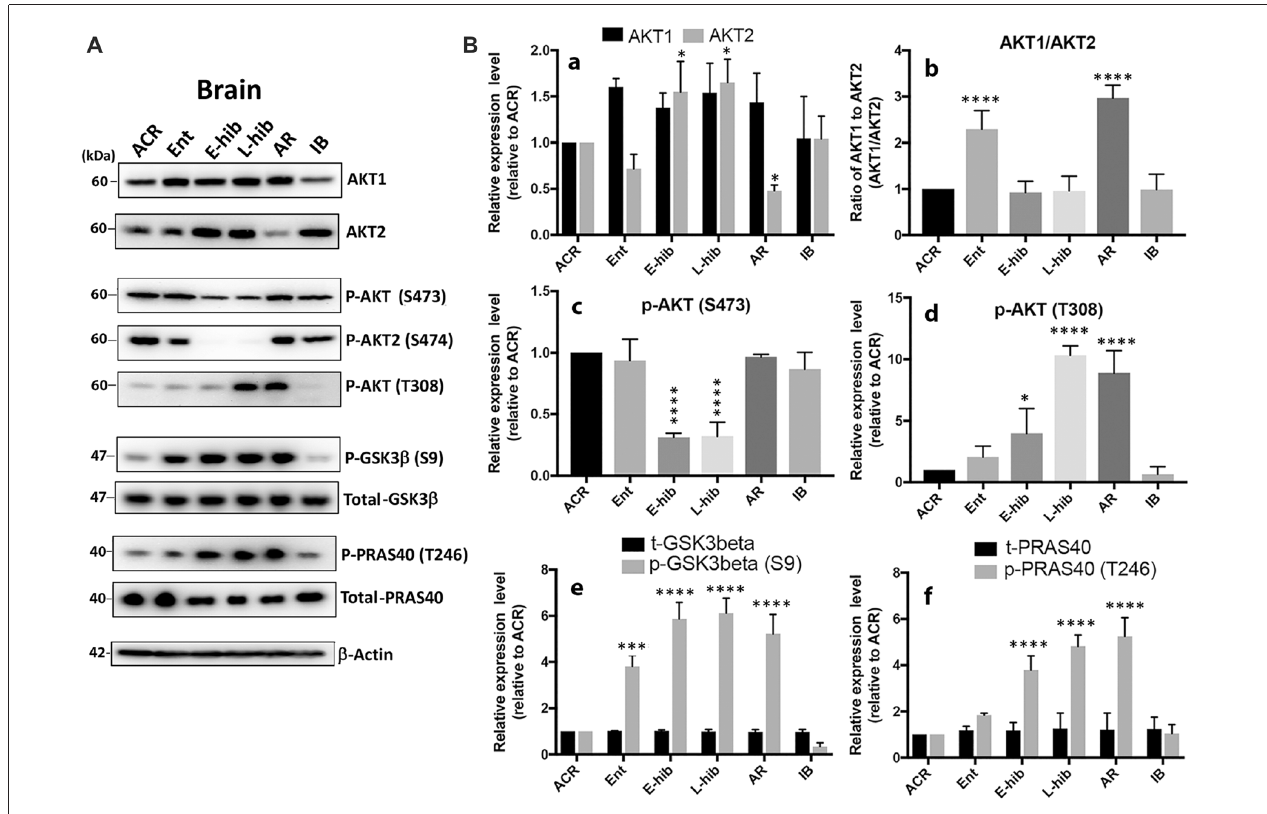
FIGURE 4 | Akt isoforms (Akt1 and Akt2) are differentially expressed in the brain of 13-lined ground squirrels during hibernation bout. (A) Representative immunoblots of Akt isoforms, Akt substrates (GSK3 β , PRAS40), and their phosphorylated forms in the squirrel brain during hibernation bout. (B) Quantitative analyses of these protein expressions. (a) Akt1 and Akt2; (b) the ratio of Akt1/Akt2; (c) p-Akt (S473); (d) p-Akt (T308); (e) total- and phosphor- GSK3 β (t- and p-GSK3 β ); (f) total and phosphor-PRAS40 (t- and p-PRAS40). ACR, active in cold room; Ent, entrance; E-hib, early torpor; L-hib, late torpor; AR, arousal; IB, interbout. Quantitation data represent the mean ± SD of at least four different brain samples from each stage of hibernation bout. The statistical analyses were shown relative to the ACR group. ∗ p < 0.05, ∗∗∗ p < 0.001, ∗∗∗∗ p < 0.0001.